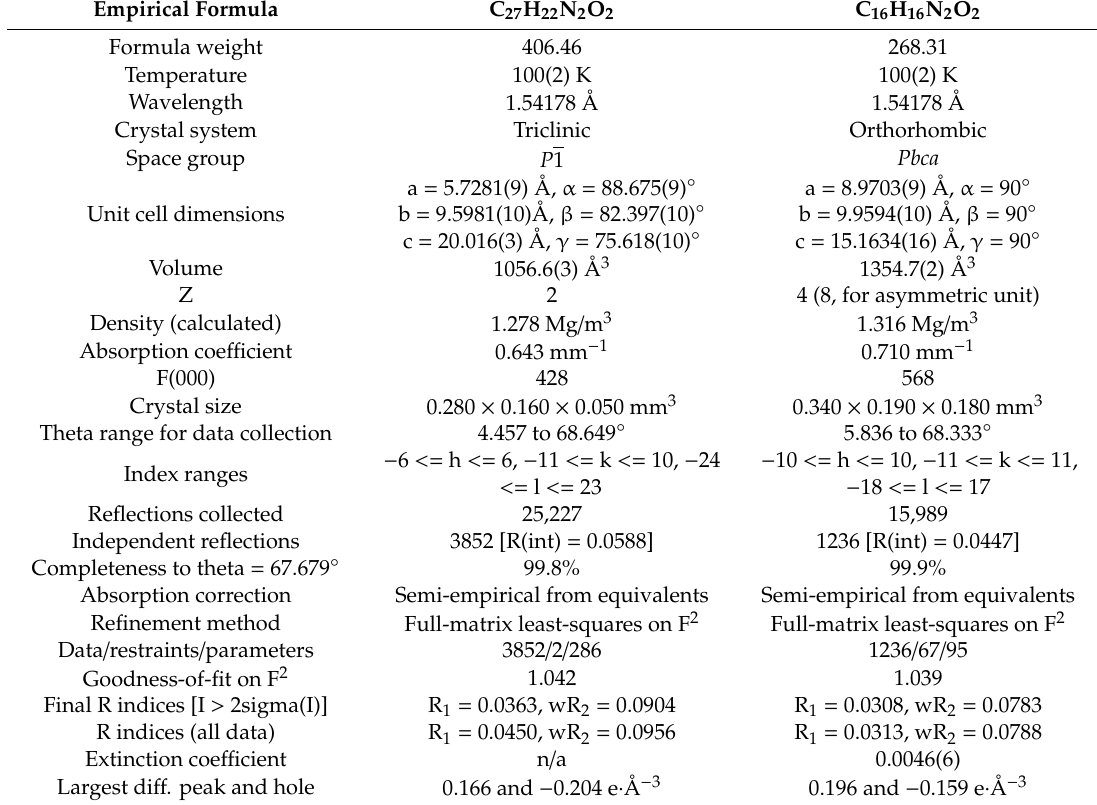
Table 1. Crystal data and structure refinement for BZ2 and BZ6.